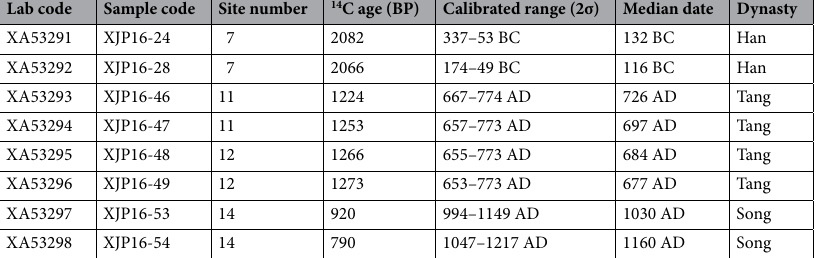
Table 1. AMS 14 C dates obtained on ancient reeds from select study